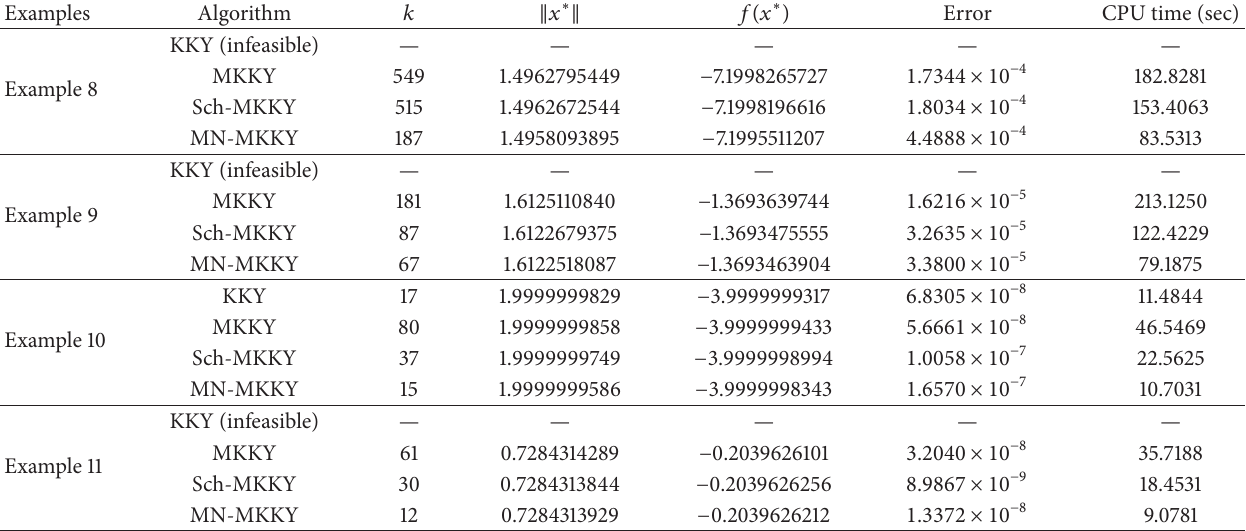
Table 2: Comparison between four different algorithms for Examples 8, 9, 10, and